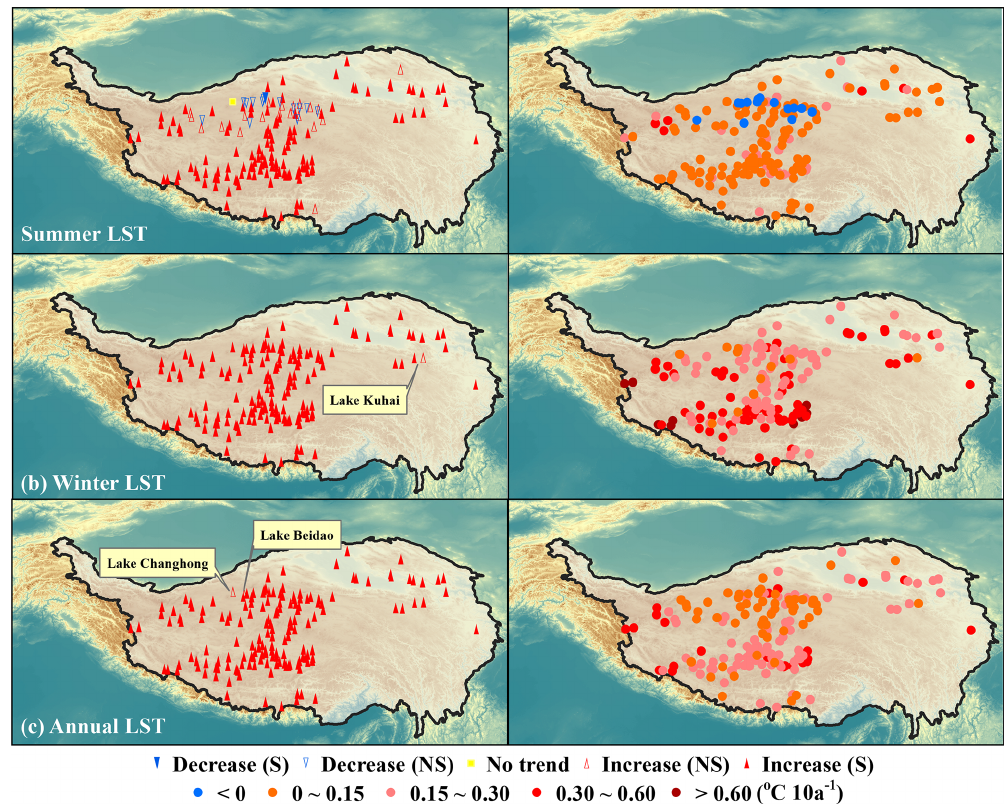
Figure 7. Long-term trends of summer (June–August), winter (December–February), and annual LSWT during 1978–2017. Table 1. Data